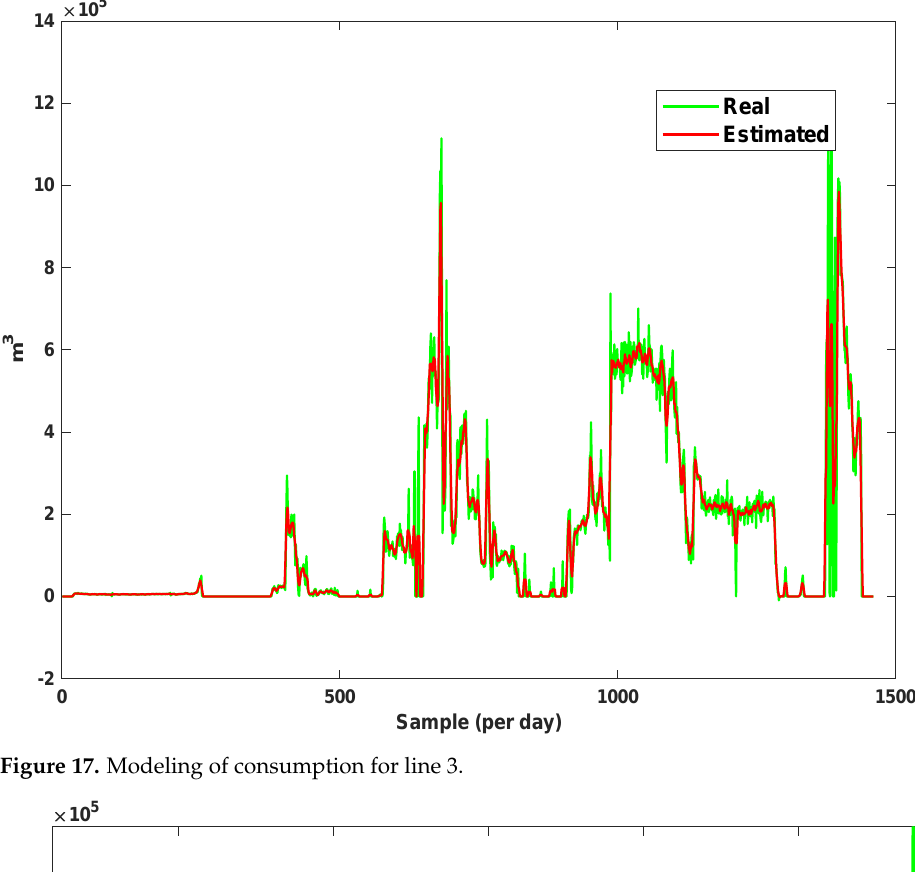
Figure 17. Modeling of consumption for line 3.